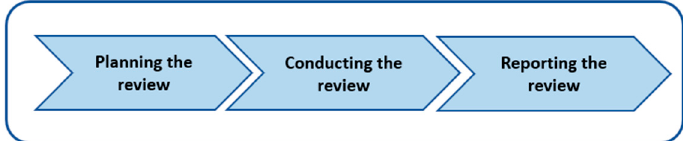
Figure 2. Literature Review Research Methodology.